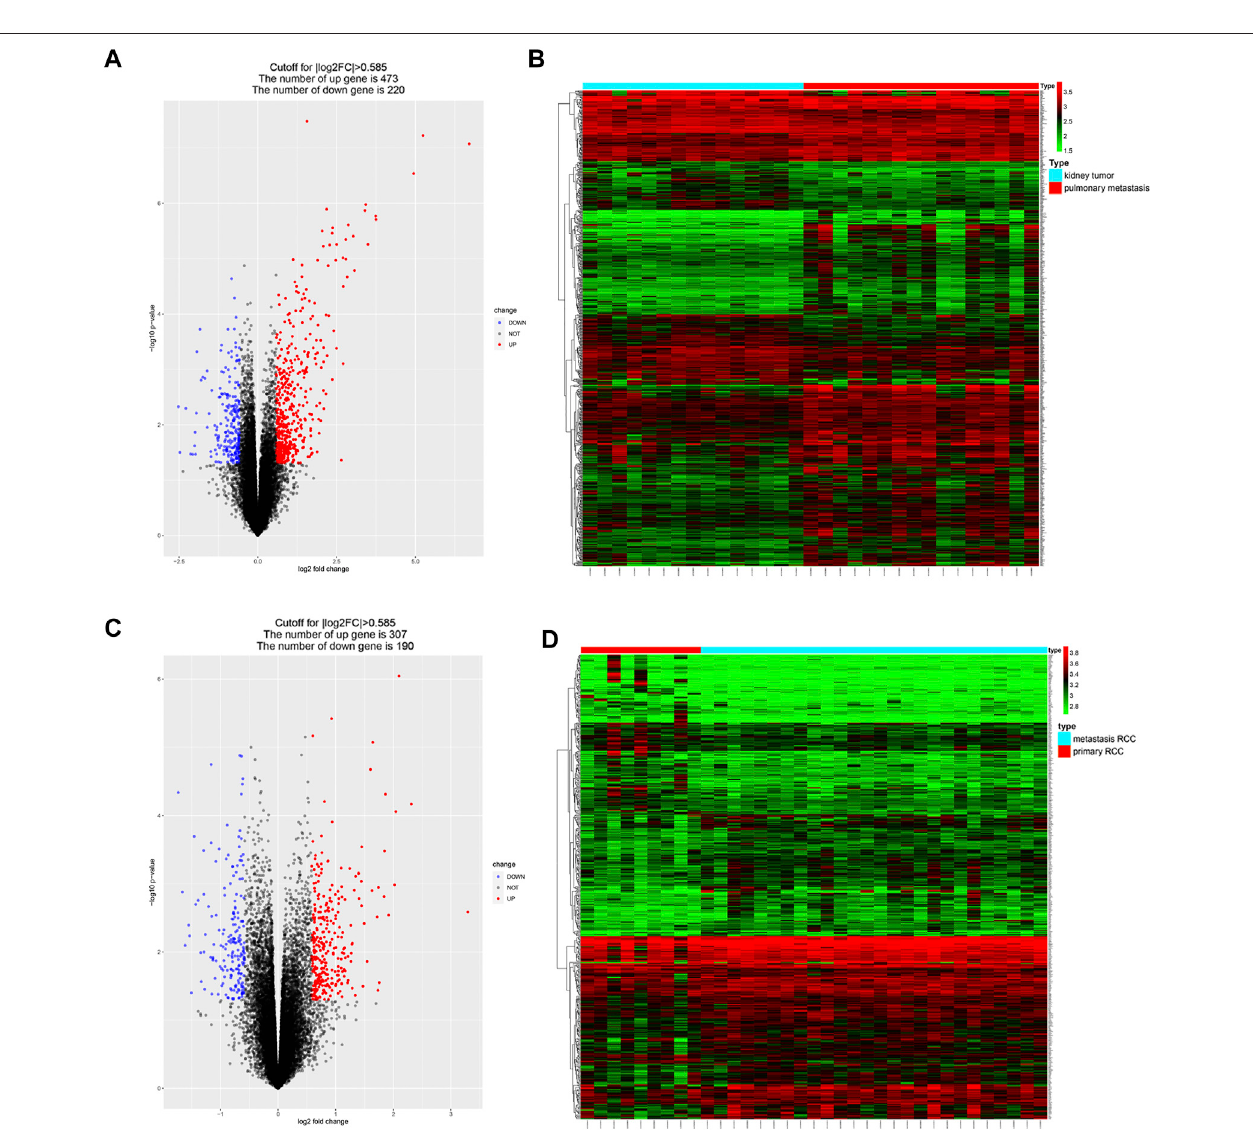
FIGURE 1 | Identi fi cation of metastasis-associated genes in ccRCC. (A – D) Volcano plots and heatmaps of the DEGs in GSE85258 and GSE105288.